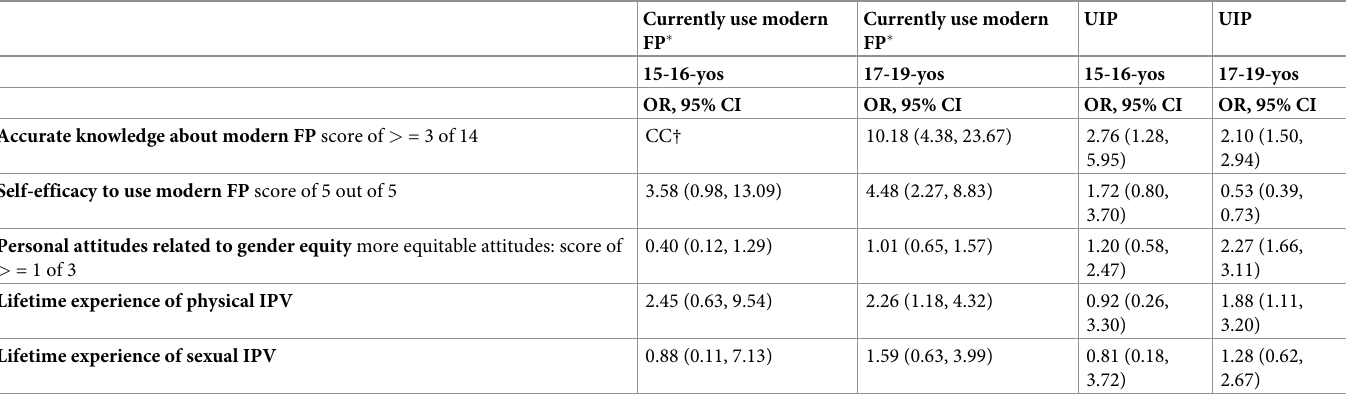
Table 5. Crude associations between reproductive health, gender equity, and partner violence factors with current modern FP use and UIP experienced among mar- ried AGYWs in Dosso region, Niger, stratified by age, 15-16-year-olds and